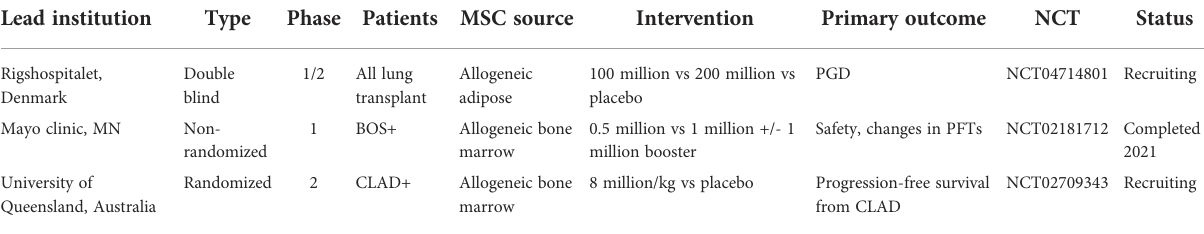
TABLE 2 Currently registered clinical trials of mesenchymal stromal cells (MSCs) in lung transplant recipients. Lead